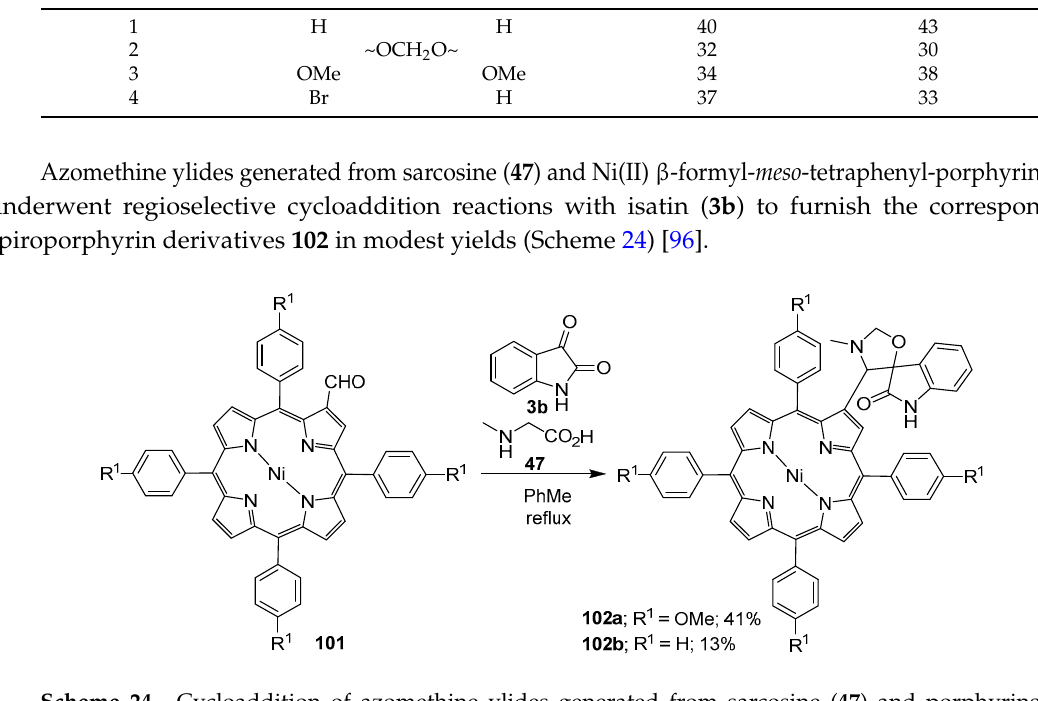
Table 14. Ring-contraction of benz-1,2,6-oxadiazepines 99 to indazole- N -oxides 100 and formation of 3-methyl-5-aryloxazolidines 82b – e (Scheme 23). Indazole- N -oxides 100 Oxazolidines 82 Entry R 1 R 2 % Yield % Yield H H